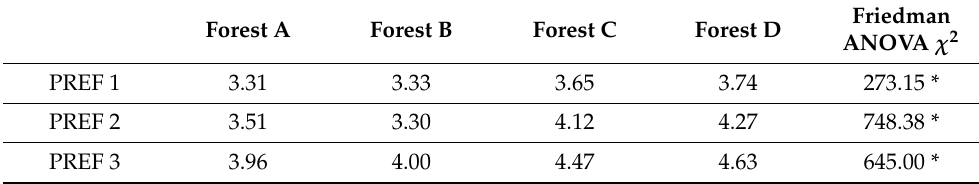
Table 3. Relation between forest development level and its preference